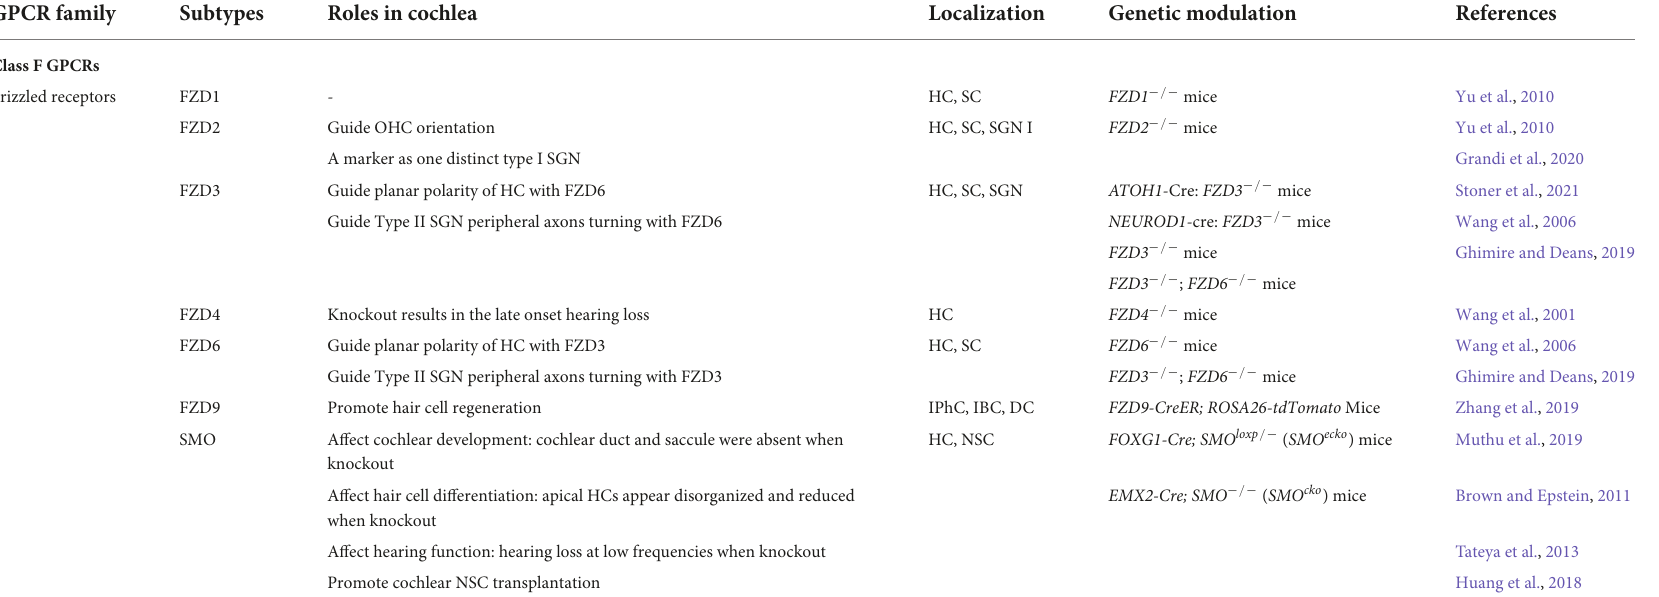
TABLE 5 Class F GPCRs relevant to